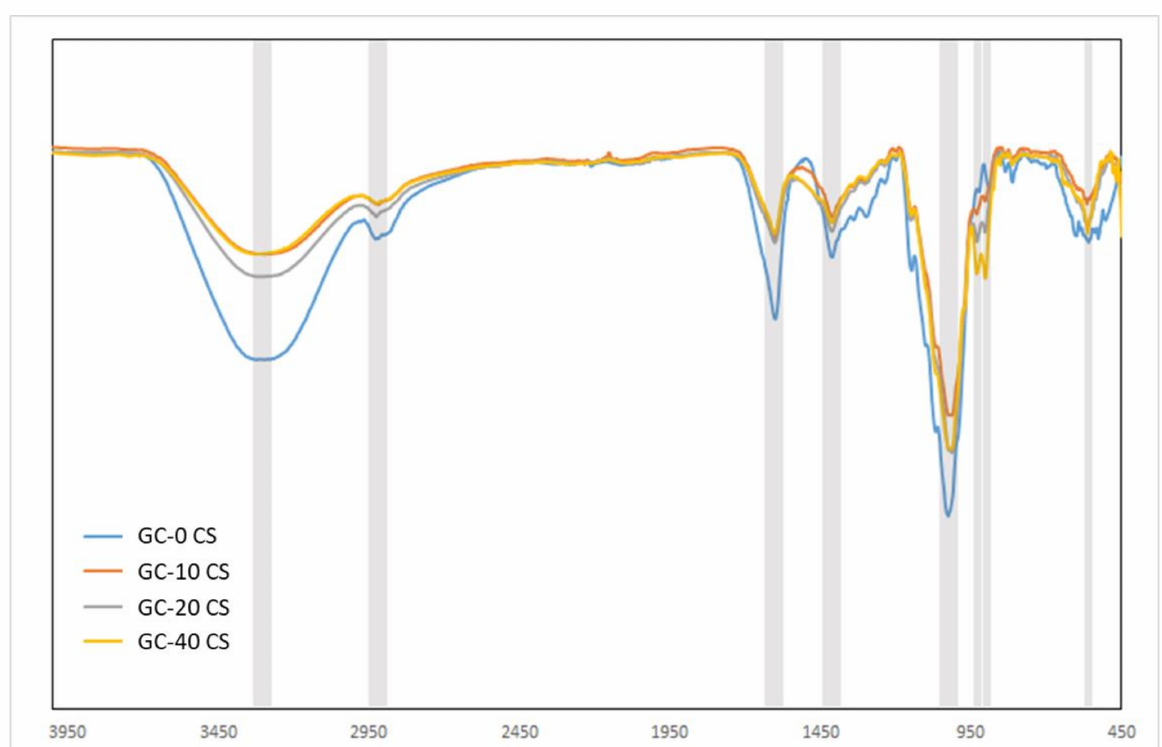
Figure 2. Fourier transmission infra-red spectra of GC-0 CS, GC-10 CS, GC-20 CS, and GC-40 CS